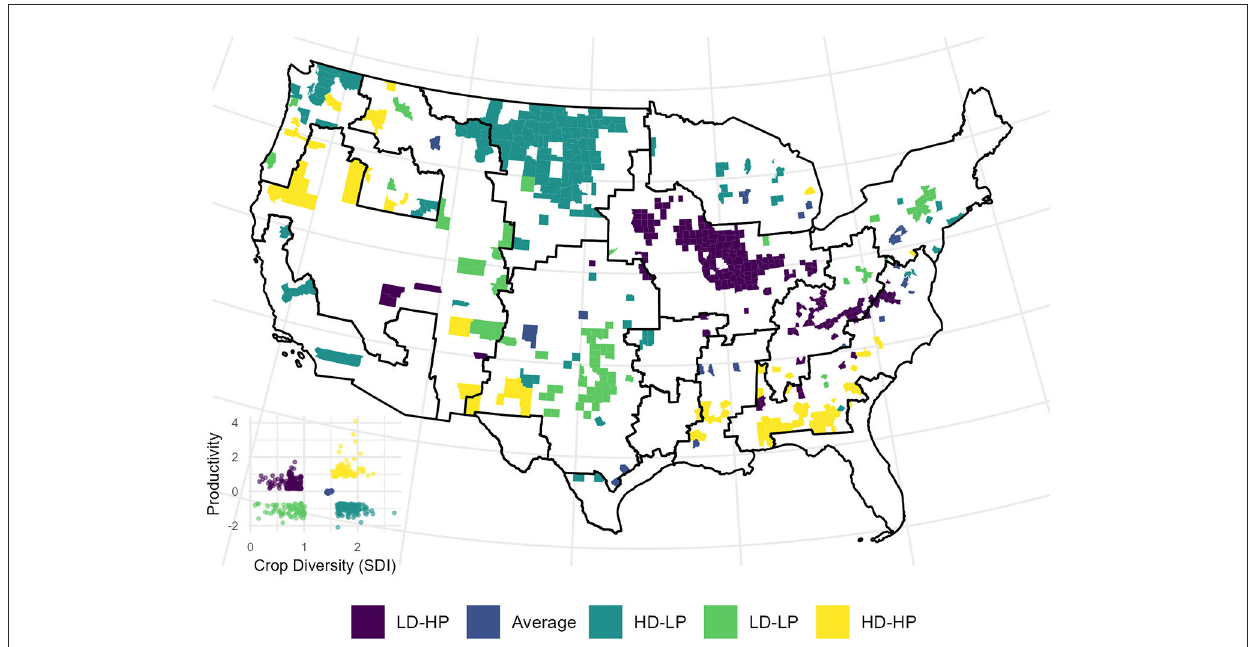
FIGURE2 Spatial distribution of the subset of archetypal counties and scatter plot (inset) of diversity and productivity for each class. Black borders indicate boundaries for USDA Farm Resource Regions (FRRs).